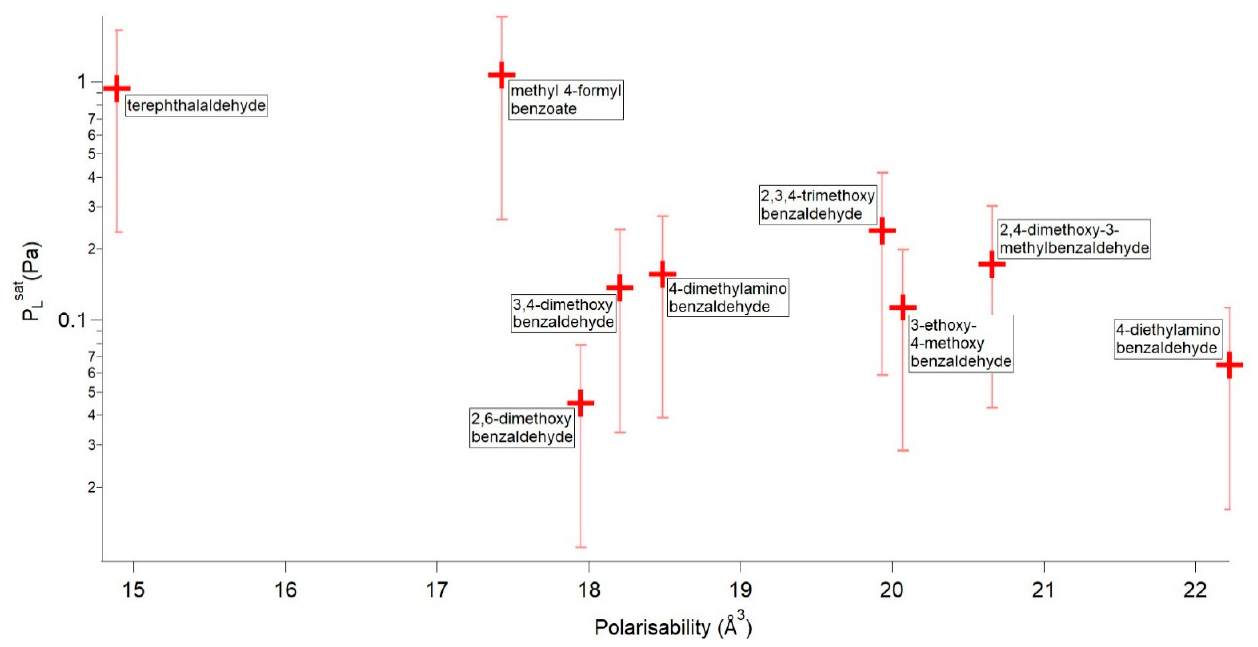
Figure 6. (cid:1842) (cid:2896)(cid:2929)(cid:2911)(cid:2930) vs. α m for the compounds not capable of forming H-bonds. Error bars are ± 75%. Terephthalaldehyde can be directly compared to 4-dimethylaminobenzaldehyde and 4-diethylaminobenzaldehyde. For these three compounds as α m increases (cid:1842) (cid:2896)(cid:2929)(cid:2911)(cid:2930) decreases as expected. 2,3,4-trimethoxybenzaldehyde can be directly compared to 2,4-dimethoxy-3- methylbenzaldehyde and 3,4-dimethoxybenzaldehyde. Going from 2,3,4-trimethoxyben- zaldehyde to 2,4-dimethoxy-3-methylbenzaldehyde reduces α m and increases (cid:1842) (cid:2896)(cid:2929)(cid:2911)(cid:2930) as ex- pected. 3,4-dimethoxybenzaldehyde can be directly compared to 3-ethoxy-4-methoxyben- zaldehyde and the trend goes as expected with an increase in α m and a decrease in (cid:1842) (cid:2896)(cid:2929)(cid:2911)(cid:2930) . Methyl 4-formylbenzoate appears to be an outlier with a (cid:1842) (cid:2896)(cid:2929)(cid:2911)(cid:2930) that is much greater than expected given its α m . This is difficult to explain and requires further investigation. 2,6- dimethoxybenzaldehyde appears to be another outlier as it has a (cid:1842) (cid:2896)(cid:2929)(cid:2911)(cid:2930) that is lower than would be expected given its α m .